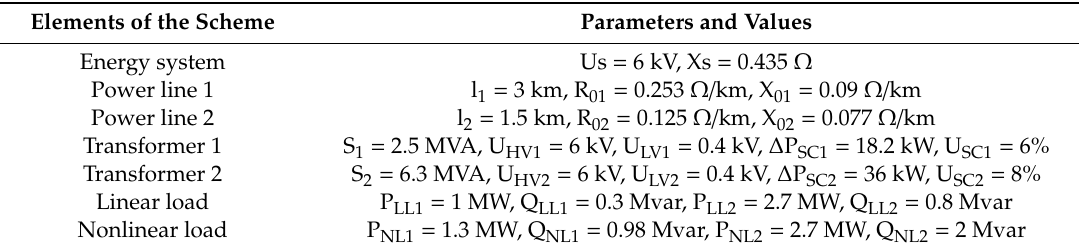
Table 1. Energy system, load, and electrical grid options.